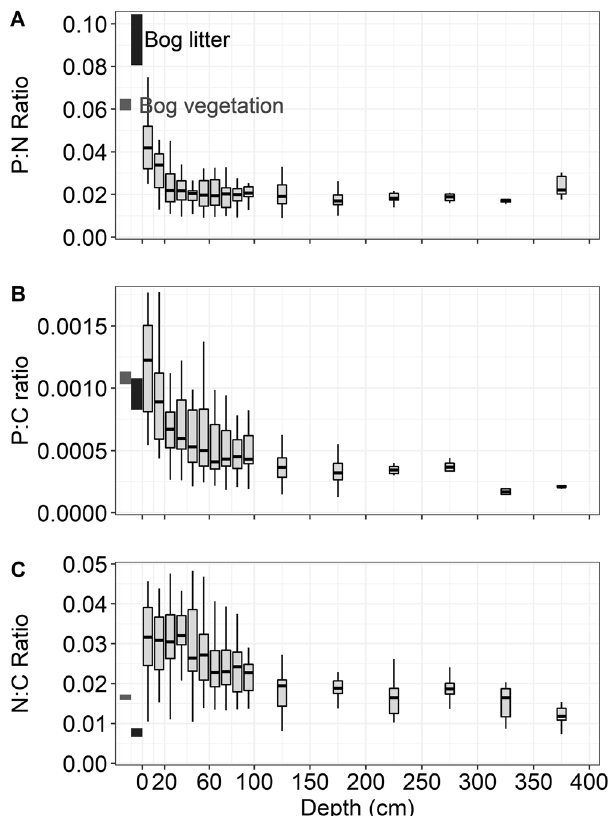
Fig. 3 Nutrient stoichiometric ratios against depth for all sites. Boxes are plotted for the ratios between ( A ) P and N, ( B ) P and C and ( C ) N and C at 10 cm horizontal intervals between 0 and 100 cm depth and then 50 cm intervals. Whiskers extend to 1.5 times the inter-quartile range. Dark and light grey rectangular boxes encapsulate the stoichiometric ratios for bog vegetation and bog litter across North America and Europe compiled by Wang et al. 24 . Vertical limits for each source material rectangle (bog vegetation or litter) are the mean ± standard error and their horizontal position is